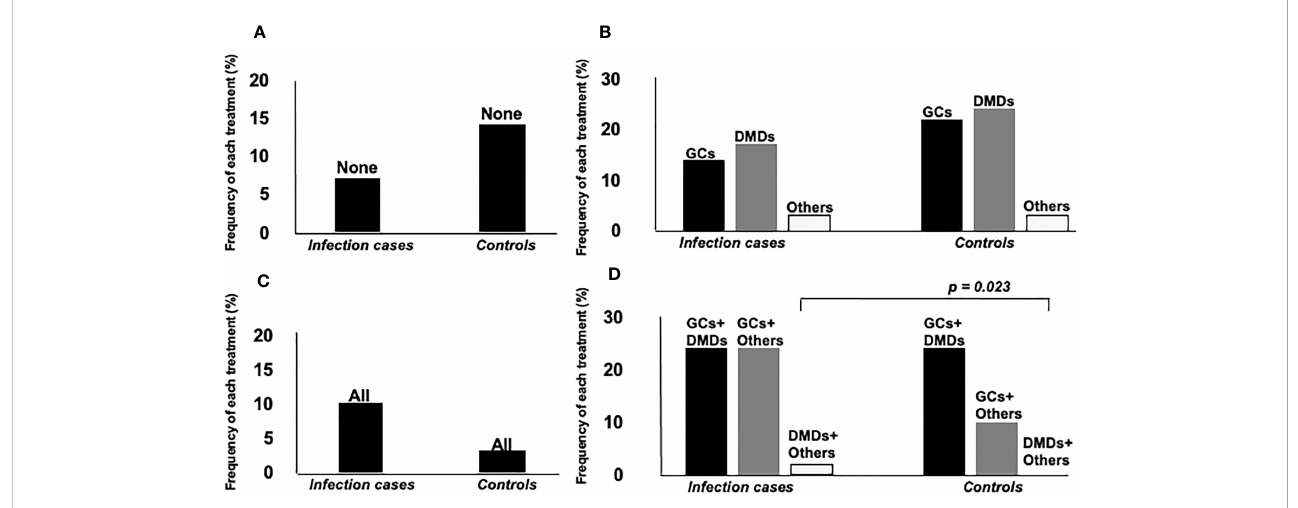
FIGURE 2 Comparison of frequency of each treatment agent between two groups. Groups were separately analyzed according to the number of treatment agents. (A) none, using no drug, (B) using only one drug, as GCs, DMDs or others (other kind of immunosuppressant; azathioprine, methotrexate, bucillamine, tacrolimus, cyclosporine), (C) all of them, (D) using two drugs, as GCs+DMDs, GCs+Others, DMDs+Others. Frequency of GCs+Others users was signi fi cantly higher in infection cases than controls.